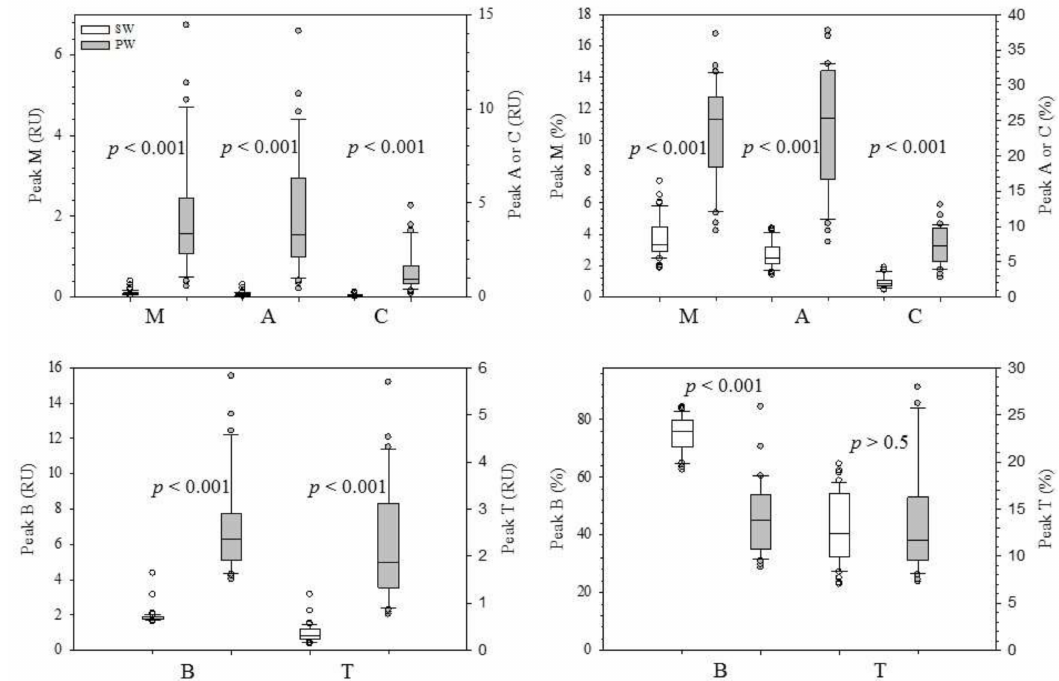
Figure 8. The examples of the comparison of the FDOM peaks between the seawaters (SW) and the pore waters (PW) from the Svalbard Fjord of the Arctic Ocean. The p -values show beside each pair denote that they are significantly different when p <